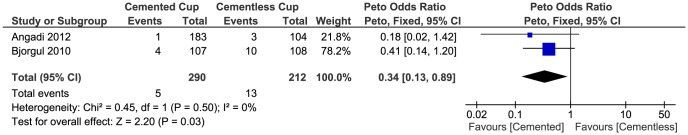
Implant dislocation of cemented cup vs. cementless cup.